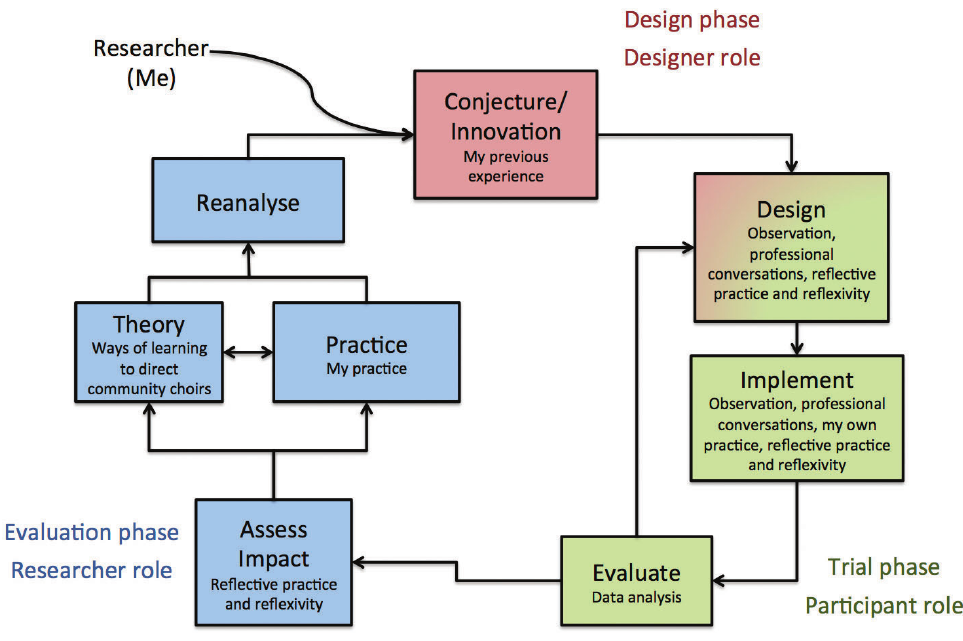
Figure 1: Design-based research model for the learning choir conductor (based on Wang and Hannafin,